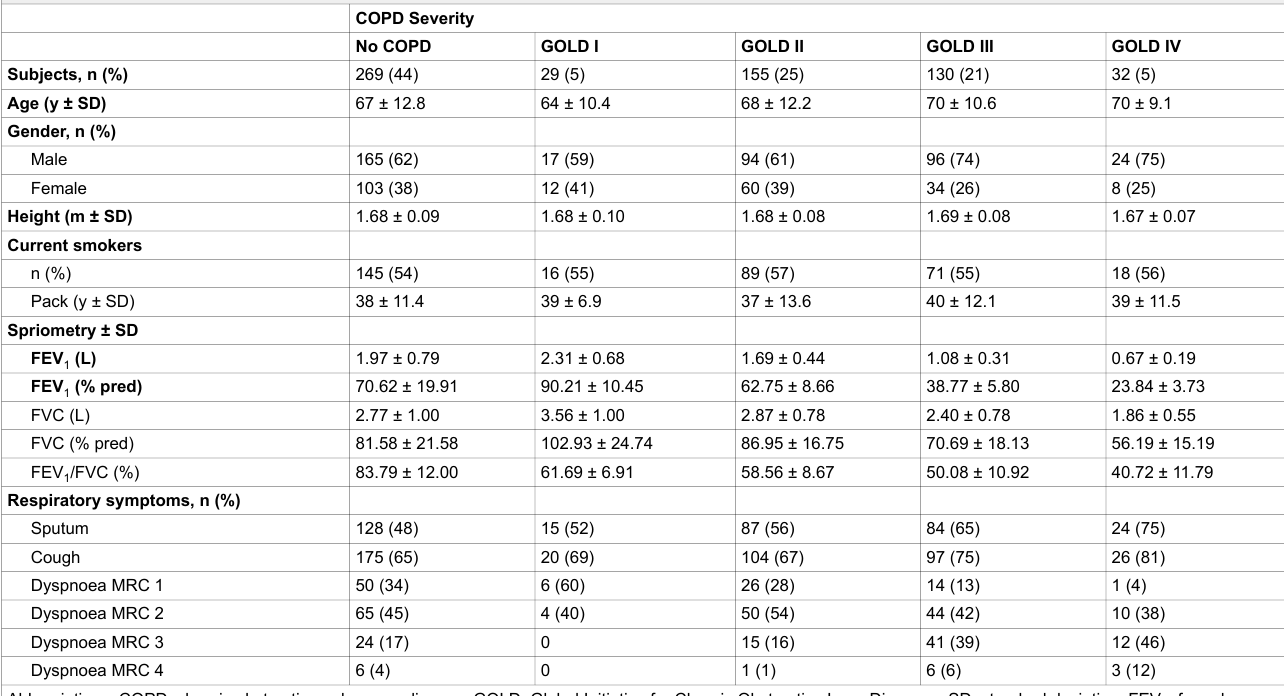
Table 2 Demographic baseline spirometry and symptom data.